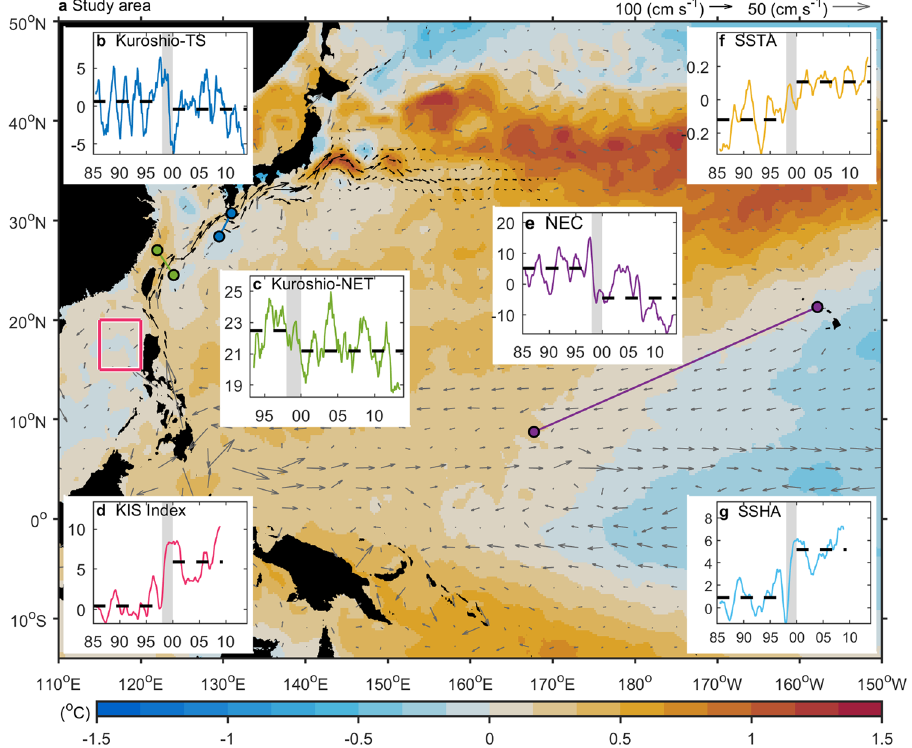
Figure 1. Ocean circulation characteristics in the western North Pacific. ( a ) SST difference (shading) (1999–2013 minus 1993–1998) and mean geostrophic velocities (vectors) in the study area. ( b ) Monthly sea level anomaly difference (in units of cm) between the Naze and Nishinoomote tidal gauges (blue dots in a ) across Tokara Strait, denoting the Kuroshio intensity. ( c ) The Kuroshio upper layer transport in the northeast Taiwan (NET, green dots in Fig. 1a) (in unit of Sv). ( d ) Index of the Kuroshio intrusion into the SCS obtained by averaging SSHA in the region of 115–120°E and 15–20°N. ( e) Monthly SSHA (in units of cm) between the Honolulu and Kwajalein tidal gauges (orange dots in a ) across the NEC. ( f) Monthly SSTA (in units of °C) over the western North Pacific (110°E–150°W and 14°S–50°N). ( g ) Same as ( f ), but for SSHA (in units of cm). In ( b–g ), the gray shading indicates the period of 1998–99, black dashed lines indicate mean